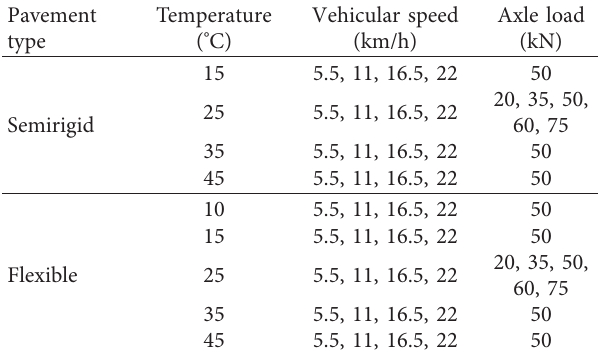
Figure 4: The photographs of (a) vehicular loading test and (b) FWD loading test. Table 2: The loading conditions in vehicular loading tests.